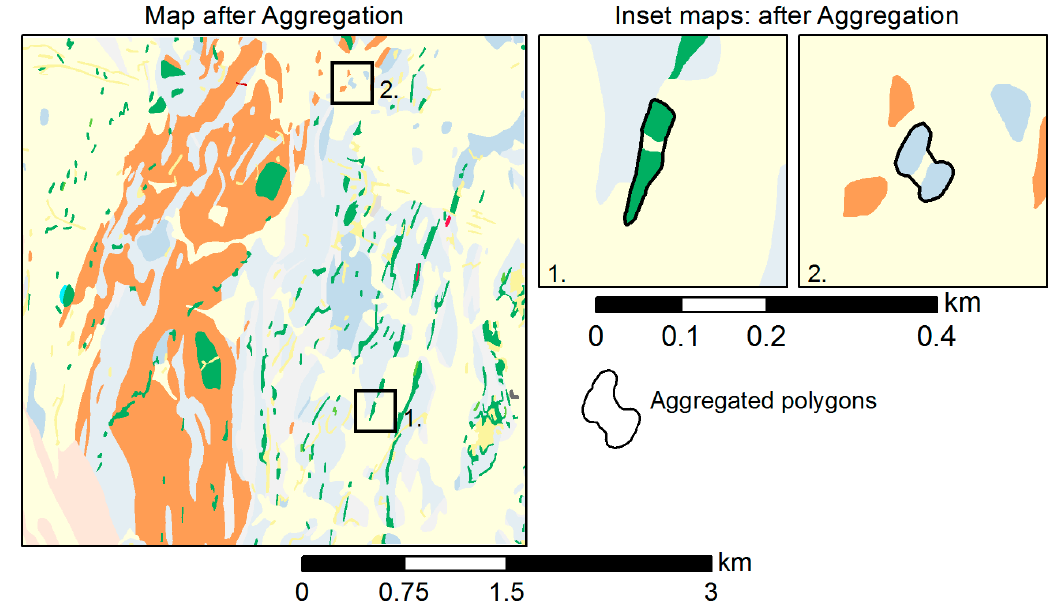
Figure 12. Part of the map after aggregation of polygons closer than the object separation (OS) threshold, including two detailed examples illustrating aggregated